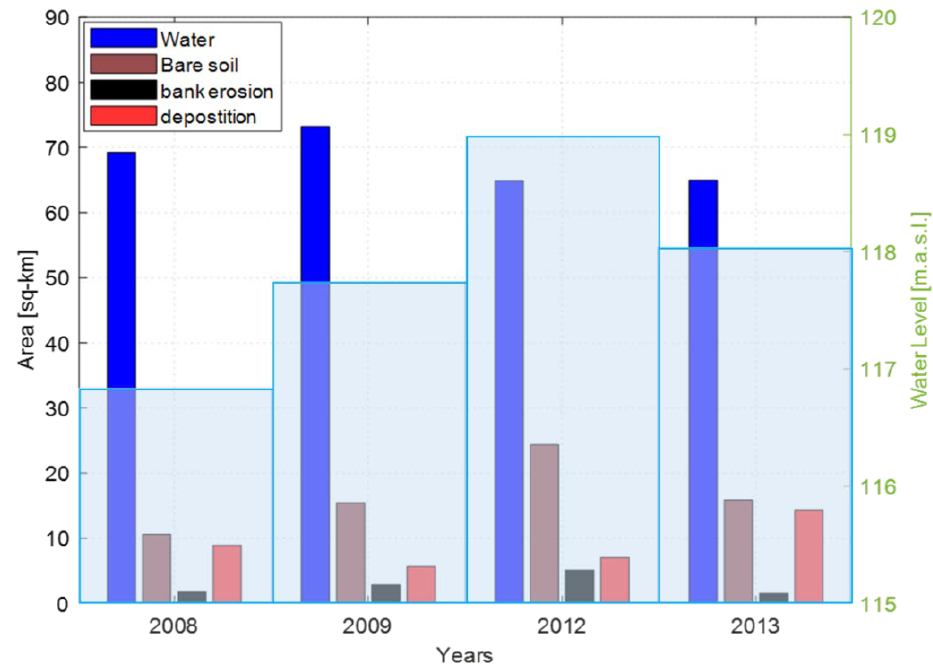
Figure 9. Bank erosion and deposition occurring in the studied